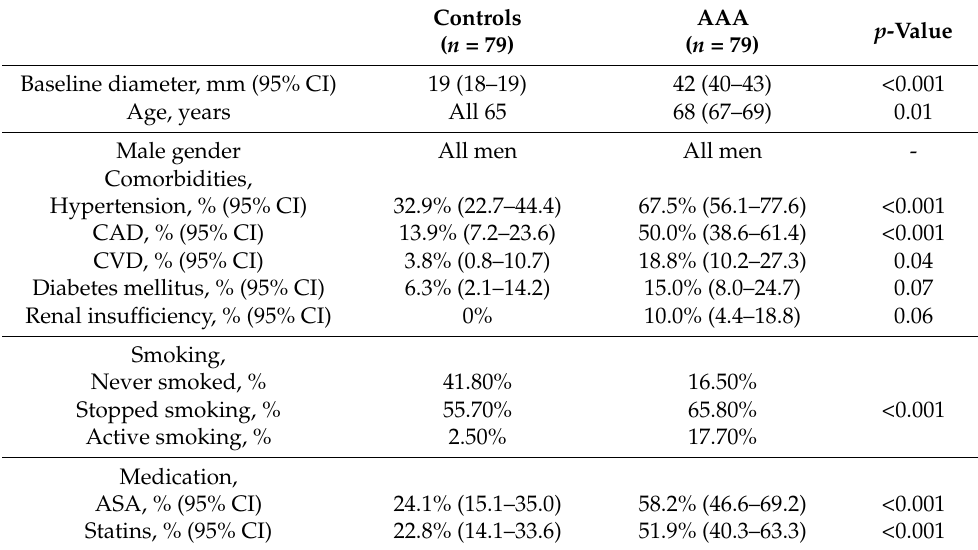
Table 1. Baseline characteristics of the study population.